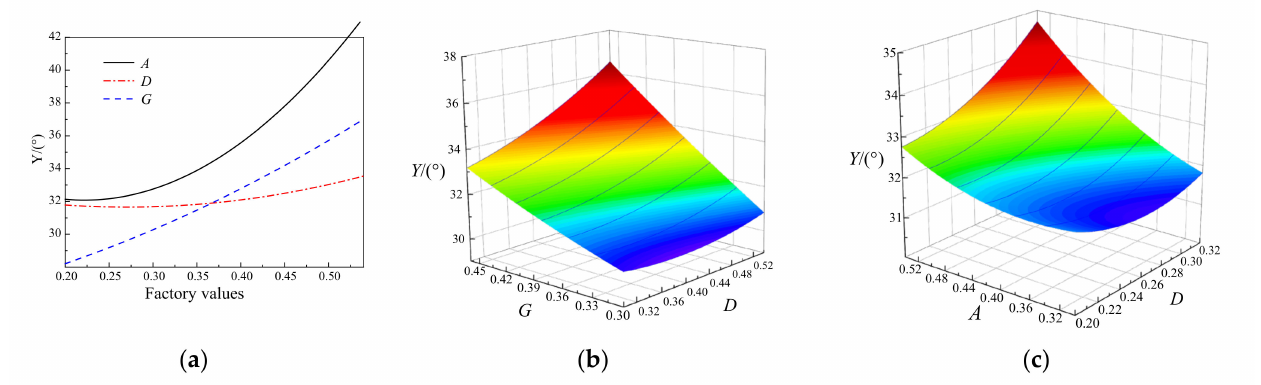
Figure 6. The influence of single factors and interaction factors on the simulation angle of repose; ( a ) single factors, ( b ) static friction coefficient between fallen jujube fruit (FJF) D and fallen jujube fruit (FJF)–steel plate G , and ( c ) Poisson’s ratio of fallen jujube fruit (FJF) A and static friction coefficient between fallen jujube fruit (FJF) D